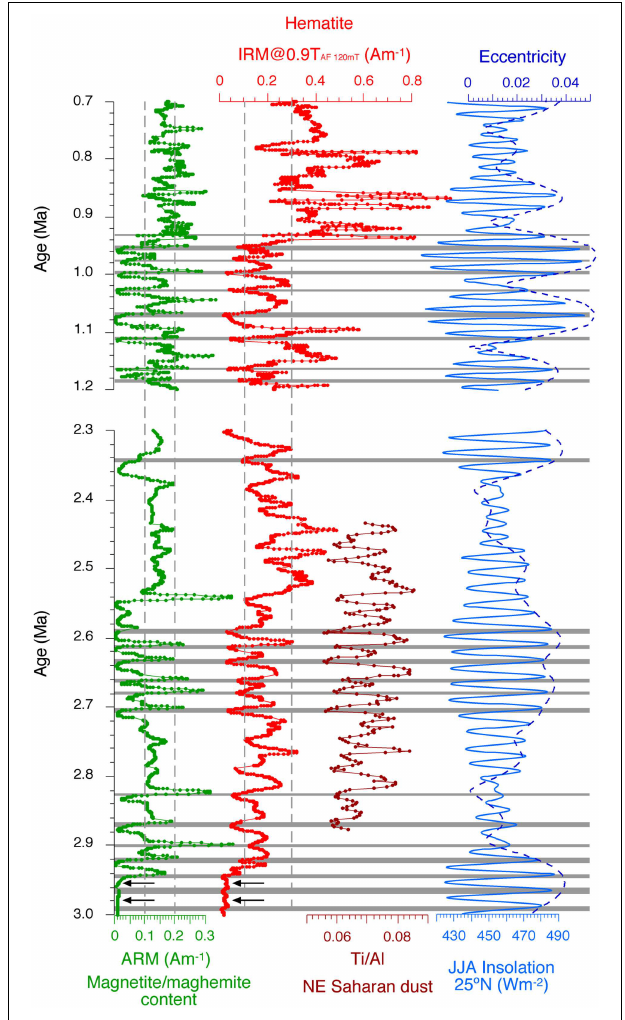
FIGURE 3 | Variations of ARM (proxy for magnetite/maghemite) and IRM@AF (proxy for hematite) through selected time intervals from Ocean Drilling Program Site 967. Gray bars indicate the positions of sapropels, and black arrows indicate the positions of extremely sulphidic sapropels. ARM and IRM@AF data are from Larrasoaña et al. (2003a,b), and Ti/Al data are from Wehausen and Brumsack